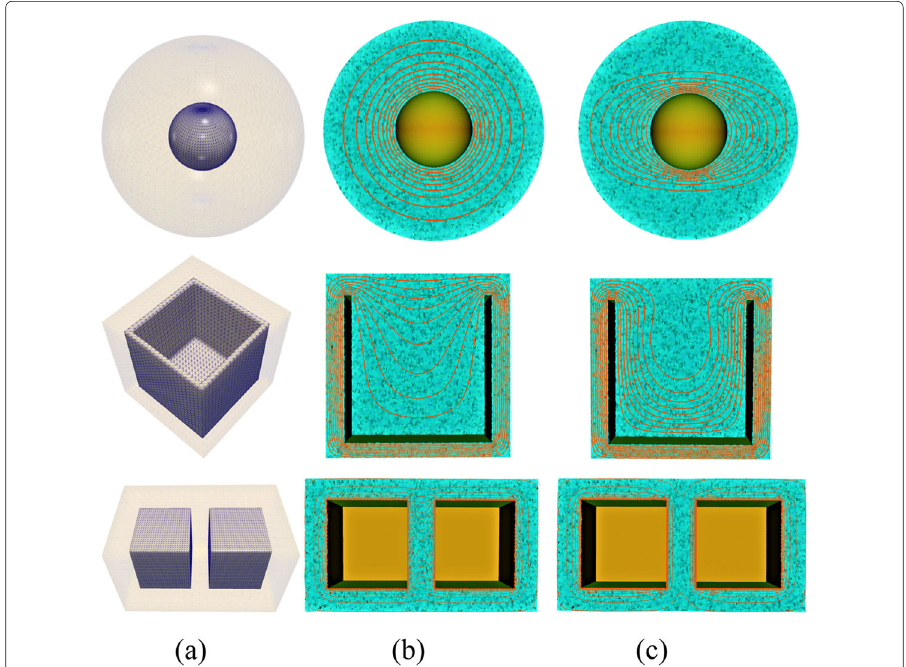
Fig. 3 Illustration of the anisotropic volume harmonic field. ( a ) The original models with Minkowski Sum boundary surfaces; ( b ) The section of iso-surfaces induced by standard volume harmonic field; ( c ) The section of iso-surfaces induced by the proposed anisotropic volume harmonic